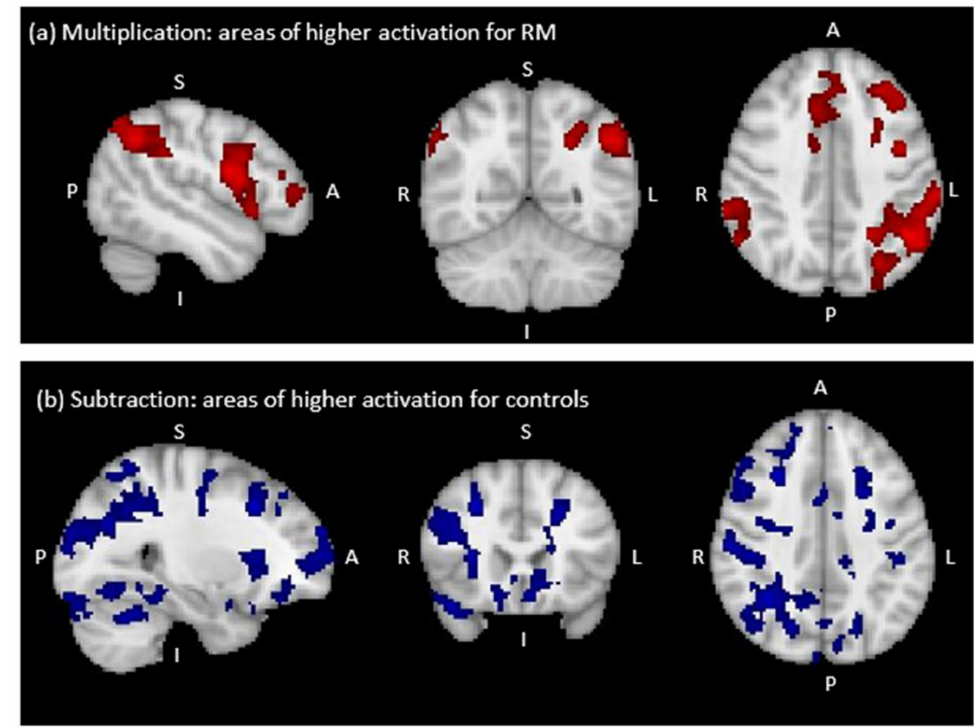
Figure 4. Regions of significant differences in BOLD signal change between RM and the control group (sagittal, coronal and axial view from left to right). ( a ) Higher activation for RM than the control group in multiplication versus control (cluster threshold Z = 2.3), ( b ) Lower activation for RM than the control group in subtraction versus control (cluster threshold Z = 3.1).